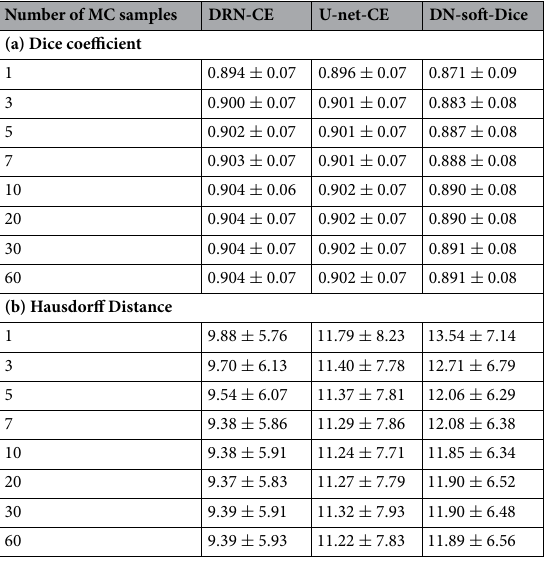
Table 5. Effect of number of Monte Carlo (MC) samples on segmentation performance in terms of (a) dice coefficient (DC) and (b) Hausdorff distance (HD) (mean ± standard deviation). Higher DC and lower HD is better. Abbreviations: Cross-Entropy (CE), Dilated Residual Network (DRN) and Dilated Network (DN).